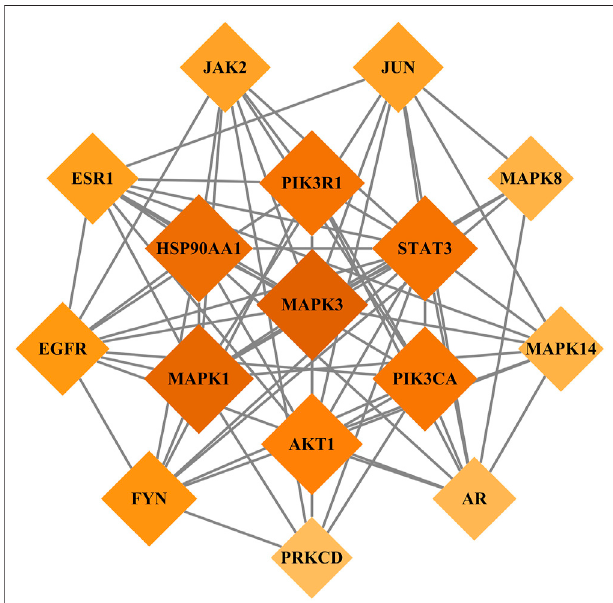
FIGURE 3 | Key target genes of the new treatment formulation for ischemic stroke with Qi de fi ciency and blood stasis syndrome. Diamonds represent target genes, with darker colors indicating increasing